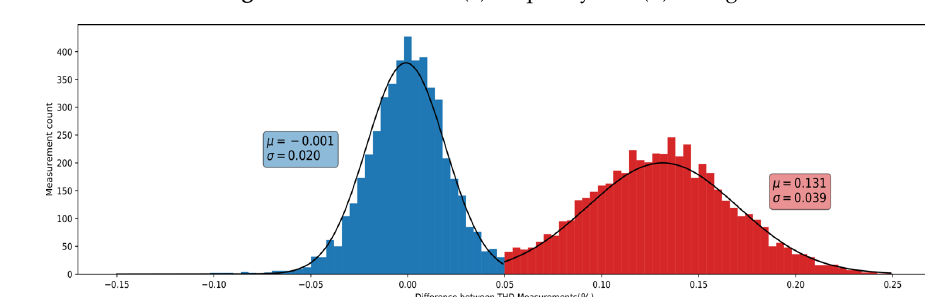
Figure 10. Validation of ( a ) frequency and ( b ) voltage.